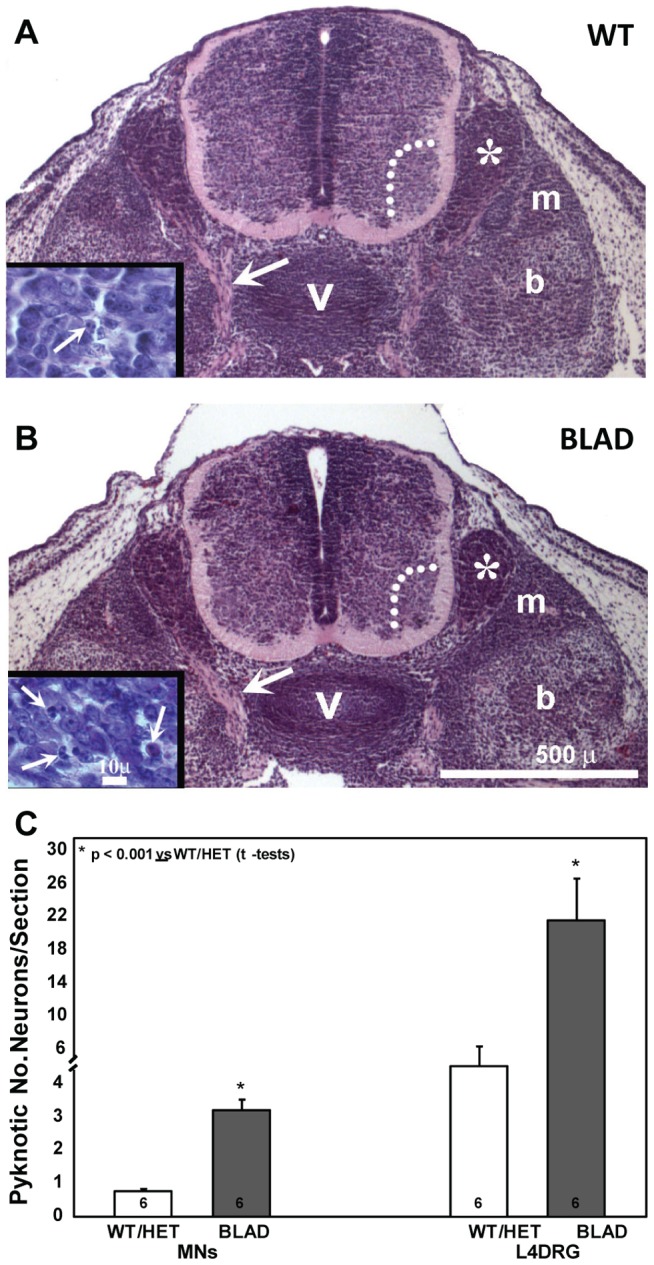
Lumbar spinal cord and pyknotic neurons at E13.5.A, B: transverse sections of caudal lumbar spinal cord of WT (A) and Nmnat2blad/blad (B) embryos. Large arrows in A and B indicate proximal axons. Insets in A and B depict pyknotic DRG cells (arrows). C: numbers of pyknotic motoneurons (MNs) and DRG sensory neurons. b, bone; m, muscle; v, vertebra; asterisk, DRG; dotted lines enclose motoneurons in the ventral horn.